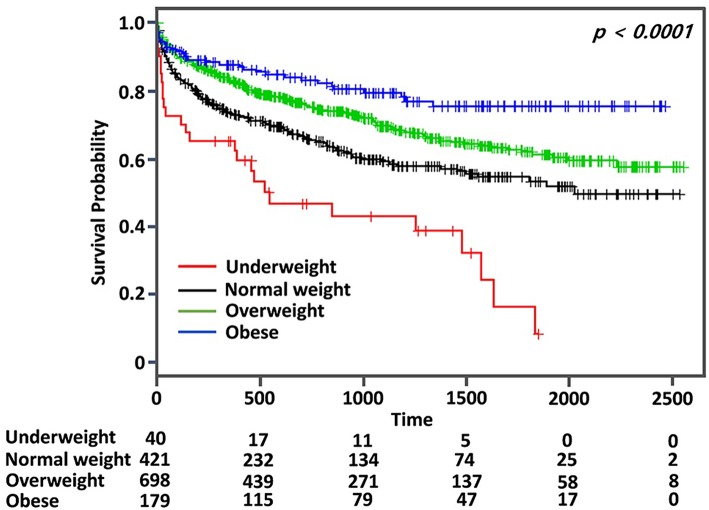
Kaplan–Meier survival analysis for major adverse cardiovascular event (MACE) according to body mass index in patients with ischemic stroke and type 2 diabetes mellitus.